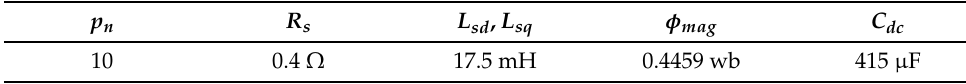
Table 1. Experimental setup parameters [43].